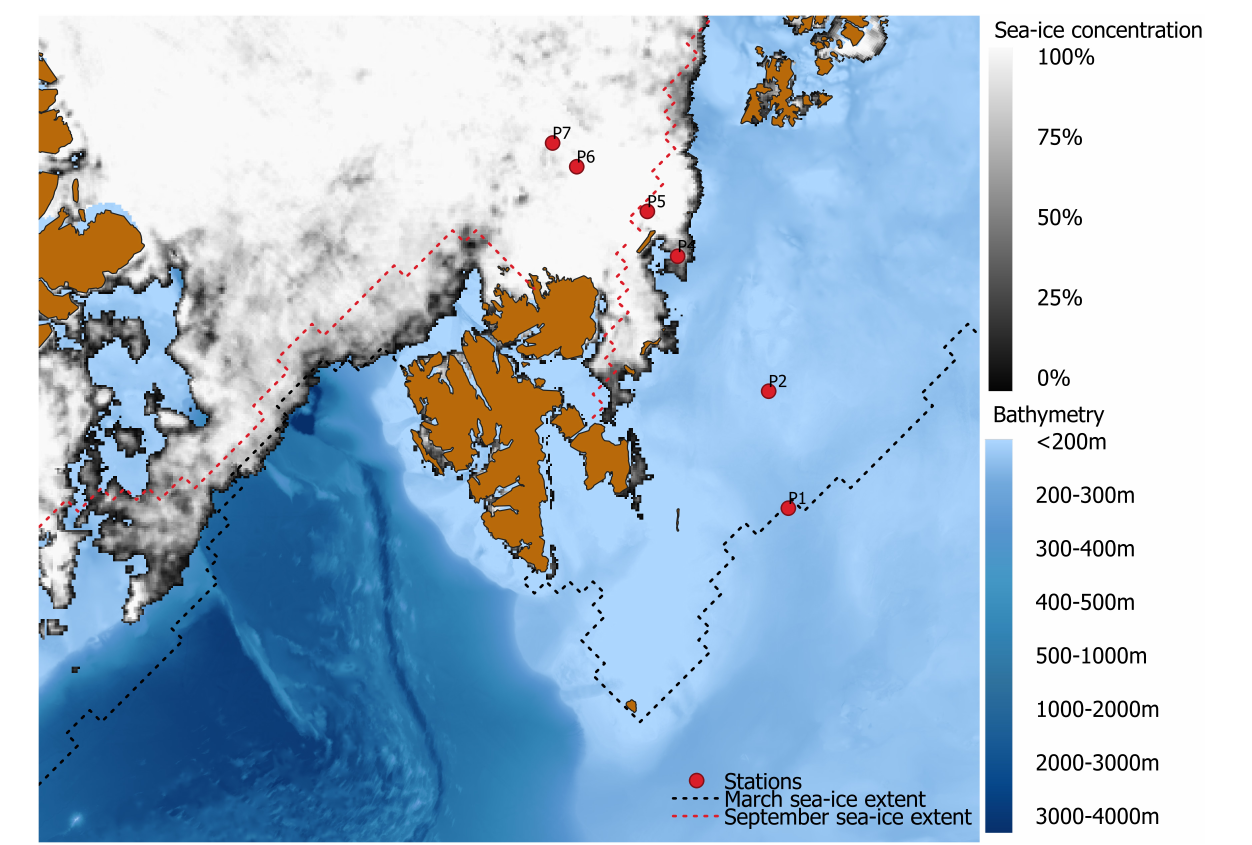
FIGURE 1 | Map showing the Nansen Legacy transect across the Barents Sea in August 2019. Sea-ice concentration ( SIC %) along the sampling transect is shown for 15 August 2019. SIC data was acquired from Bremen University (https://seaice.uni-bremen.de/sea-ice-concentration/amsre-amsr2/) (Spreen et al., 2008). Maximum sea-extent occurred in March (black stippled line), minimum sea-ice extent in September 2019 (red stippled line) [acquired from National Snow and Ice Data Center; Fetterer et al. (2017)].